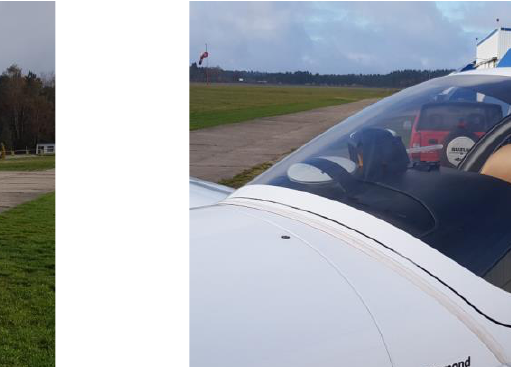
Figure 2. The Diamond DA 20-C1 aircraft taking part in the experiment and location of the GNSS antennas [45].